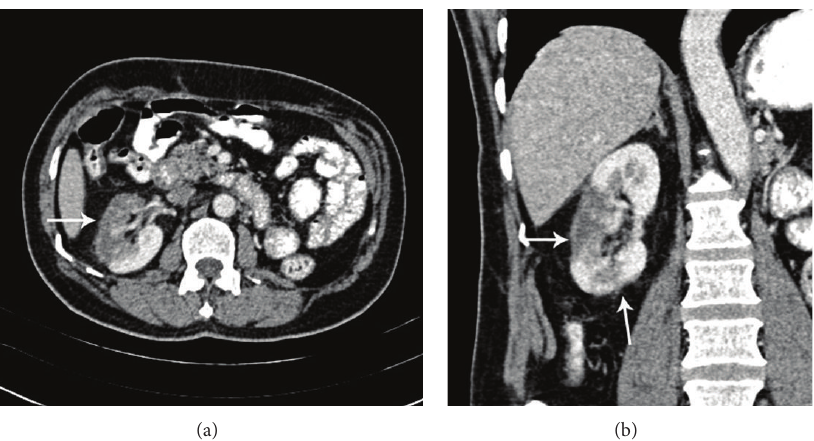
Figure 3: Findings: axial (a) and coronal (b) image of CT angiography in venous phase showing nonenhancing wedge shaped areas at mid and lower pole (arrows) of right kidney suggestive of